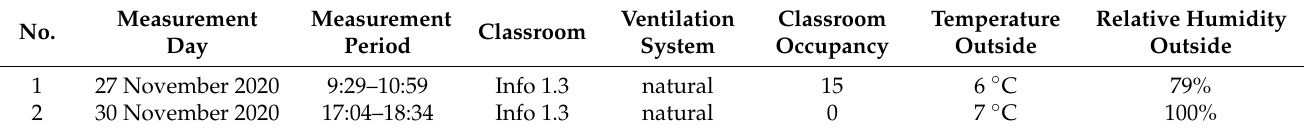
Table 1. Experimental parameters and weather conditions.